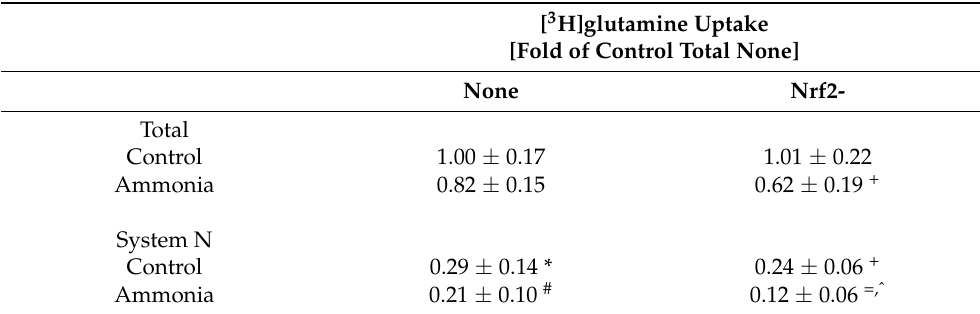
Table 1. The effect of Nrf2 silencing (Nrf2-) on total and system N-mediated [ 3 H]glutamine uptake in astrocytes in the absence or presence of 5 mM ammonia for 24 h. Basal [ 3 H]glutamine uptake was 42.93 ± 16.09 nmol/mg of protein x min.